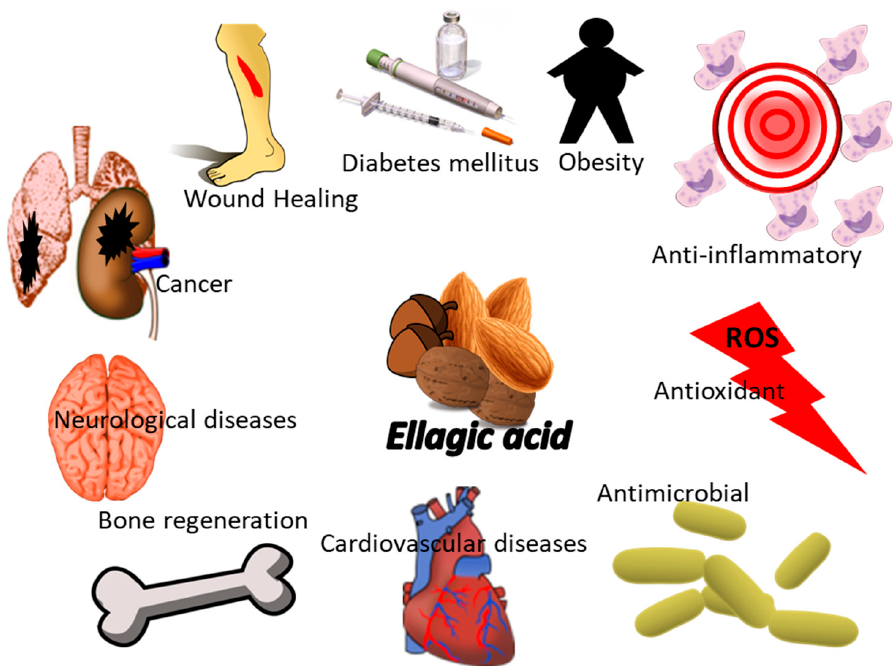
Figure 5. Biological activity of EA for human